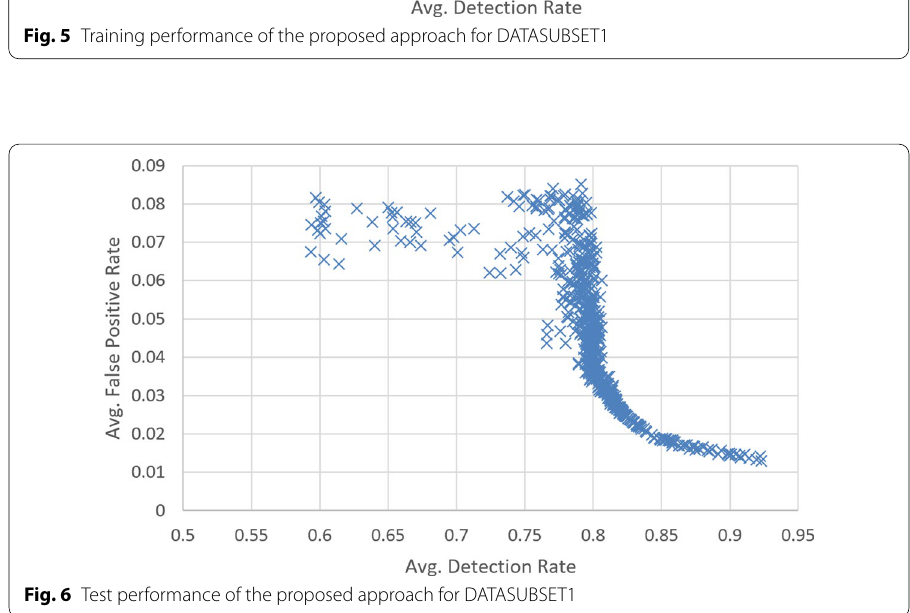
Fig. 6 Test performance of the proposed approach for DATASUBSET1